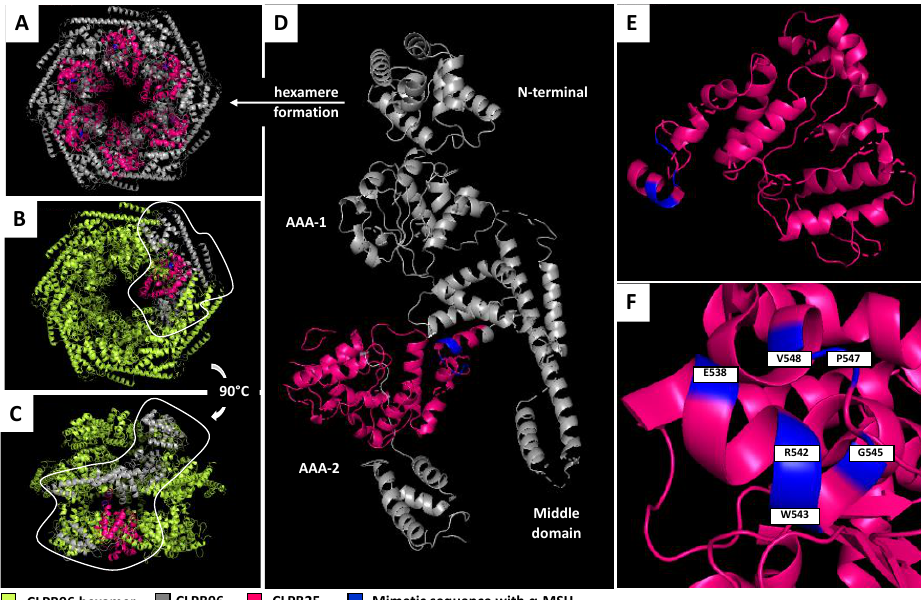
Figure 3. 3D structures of CLPB96 and CLPB25 realized by PyMOL. The 3D visualizations of the CLPB protein were carried out on PyMOL Software from the crystallization model of the CLPB protein (PDB: 4D2U). 3D structure ( A ) of the CLPB protein in its hexameric form; ( B ) in top view; ( C ) in side view; ( D ) 3D structure of CLPB96; ( E ) of CLPB25 and ( F ) pharmacophore localization. CLPB96, recombinant CLPB protein: UniProtKB-P63284 CLPB_ECOLI; CLPB25, 25 kDa CLPB fragment: Location 536–756 aa on sequence UniProtKB-P63284 CLPB_ECOLI.